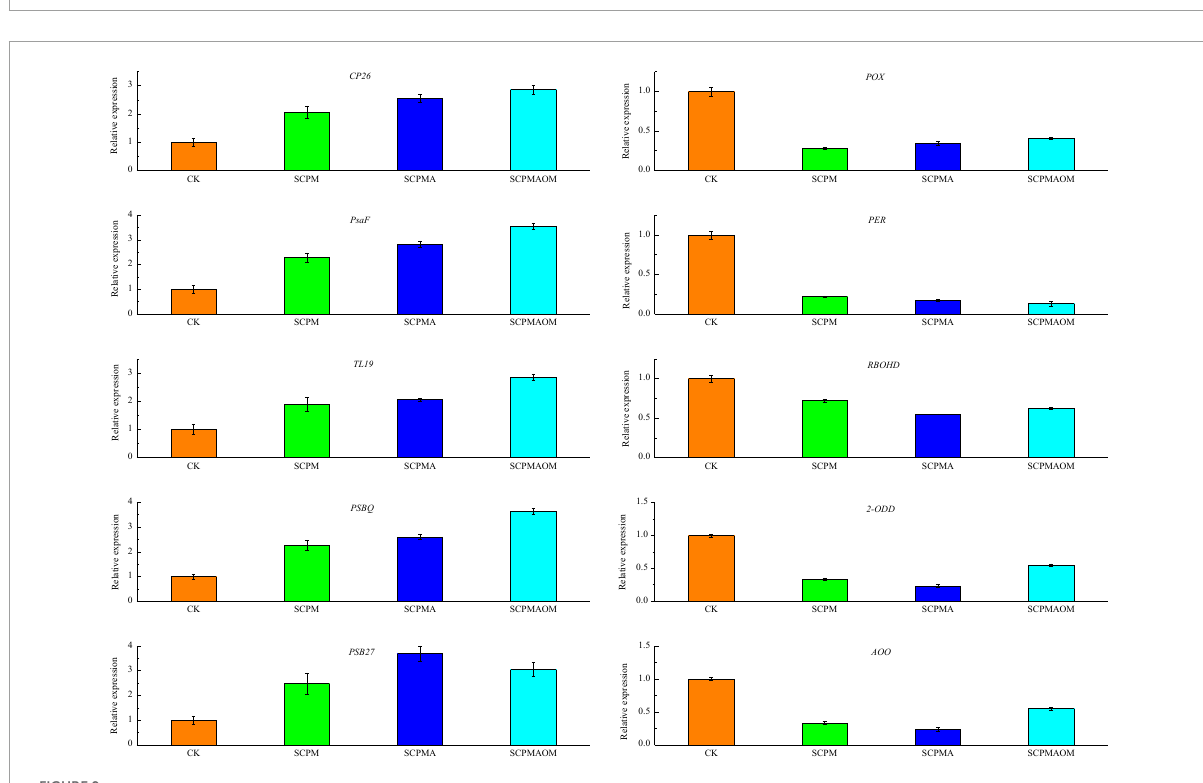
FIGURE9 The qRT-PCR analysis of 10 DEGs in the leaves of C. tangshen in different treatments. GAPDH gene was used as the reference gene for normalization of gene expression level. Three technical replicates were performed.